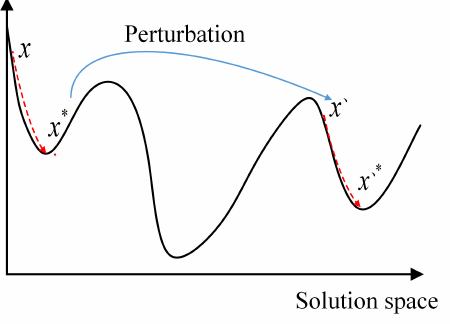
Figure 3. Basic diagram of the ILS.